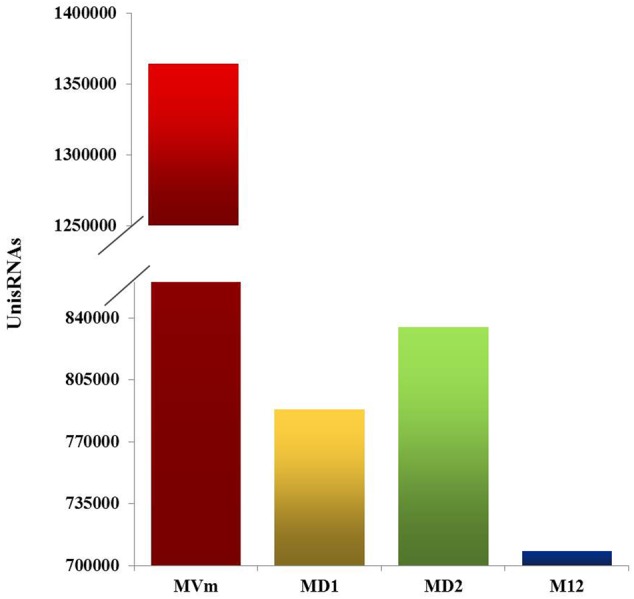
Quantification of the unisRNAs quantity in the VmDCL mutants and 03–8. Total number of uniRNAs in 03–8 and each mutants was analyzed, respectively. MVm, 03–8; MD1, ΔVmDCL1; MD2, ΔVmDCL2; MD12, ΔVmDCL1DCL2.